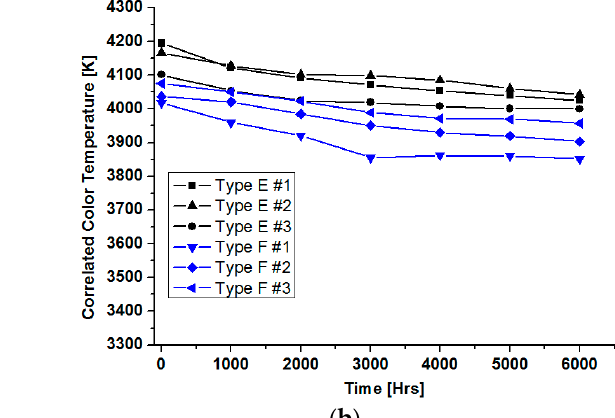
Table 5. CCT maintenance characteristics of OLED products with operating of six thousand hours.